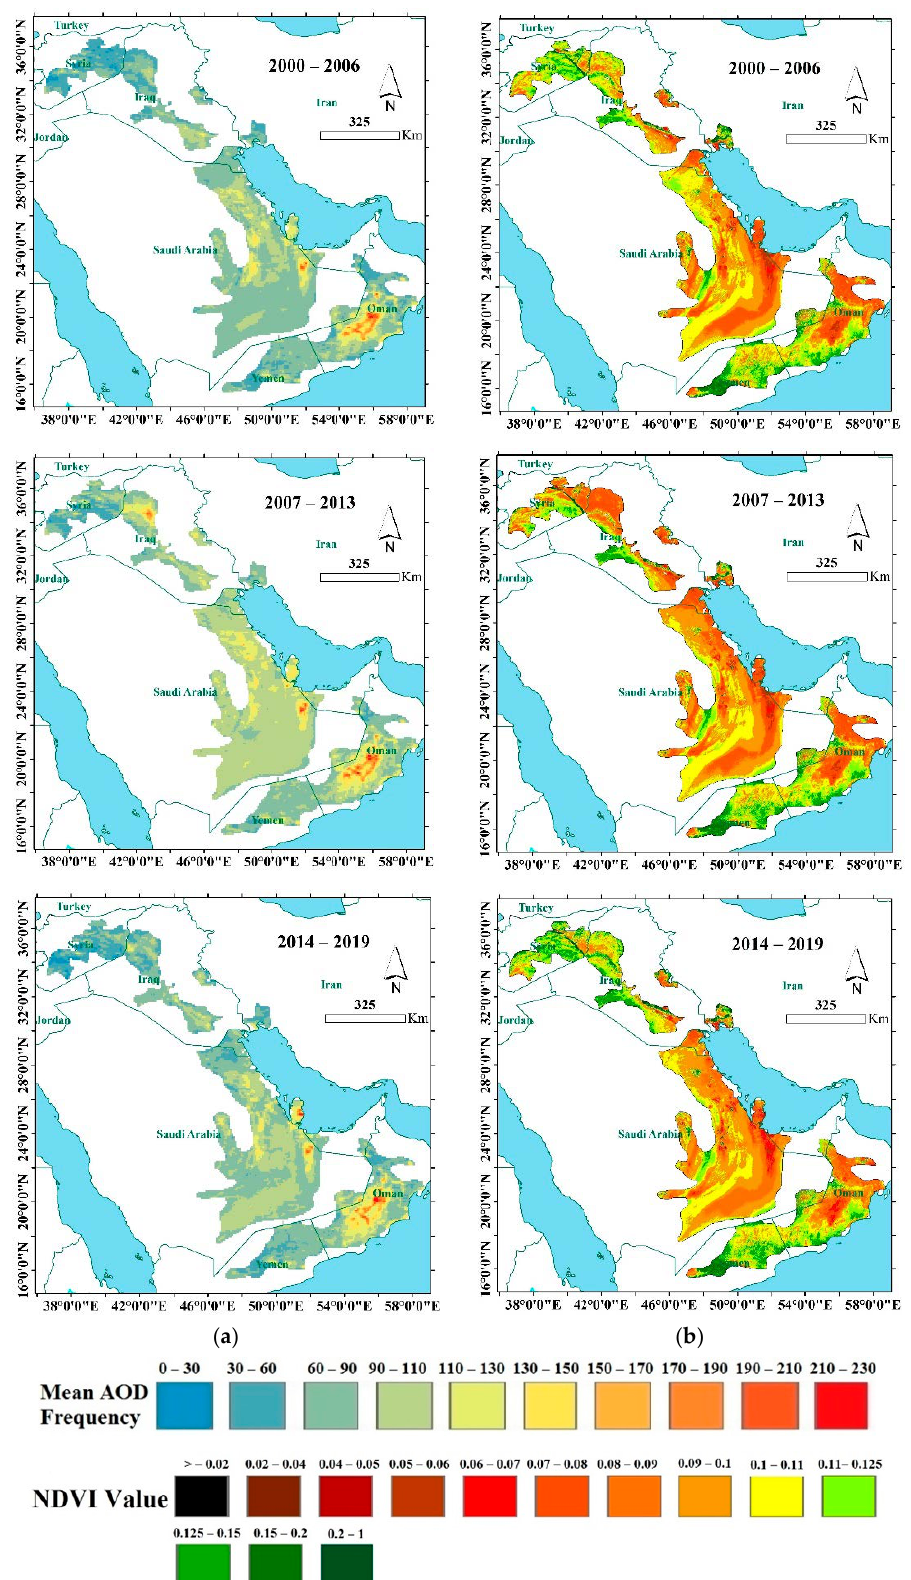
Figure 4. ( a ) AOD and ( b ) NDVI for three different periods (2000–2006, 2007–2013, 2014–2019) based on daily MODIS AOD data and 16-day MODIS NDVI data,